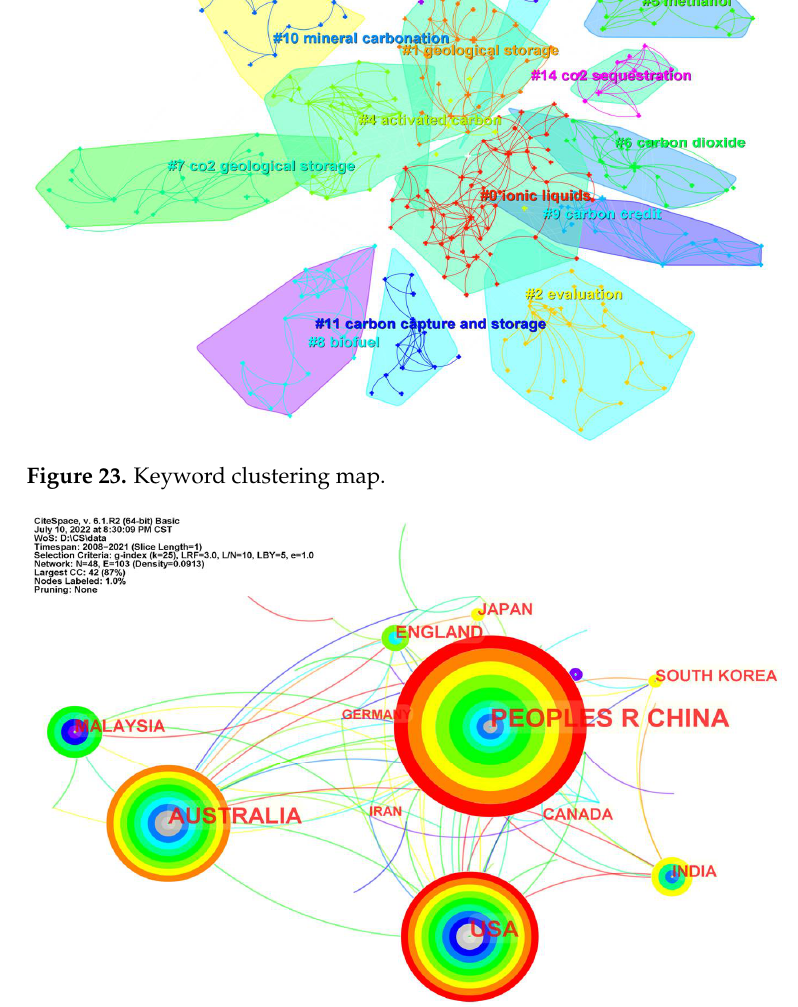
Figure 25. Organization co-occurrence map. 6.3. Keyword Highlighting Analysis It can be seen from Figure 26 that from 2012 to 2016, the mass transfer process of CO 2 is a research hotspot, and the capture and storage of CO 2 involve the mass transfer of CO 2 .